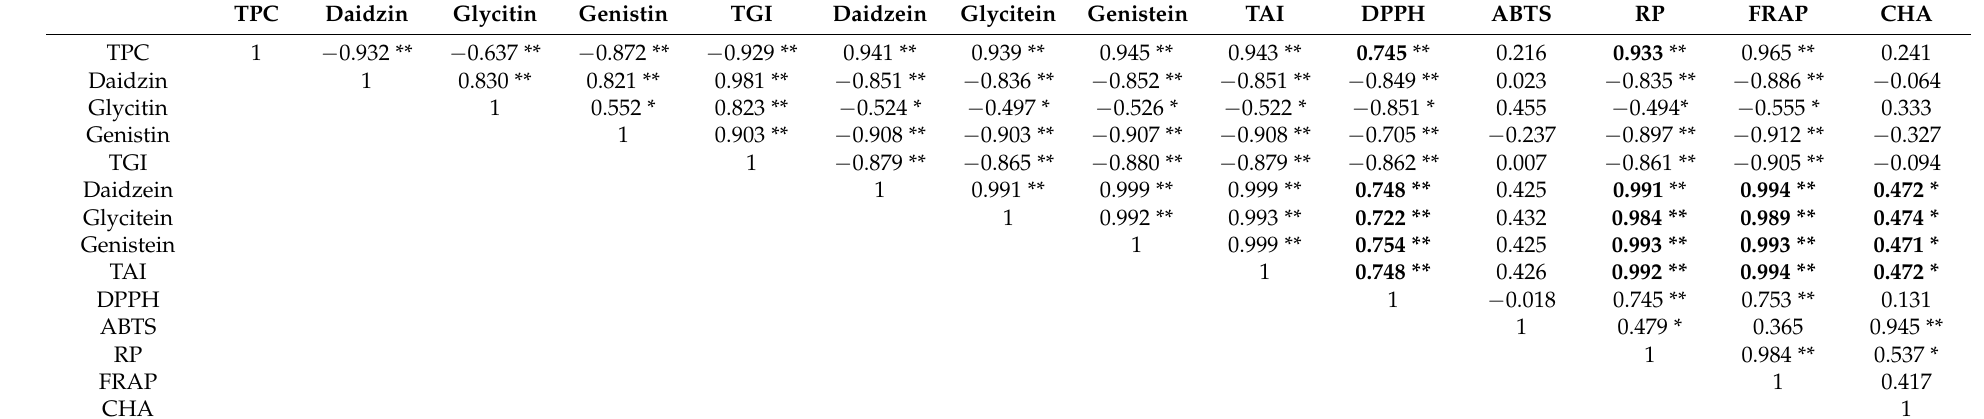
Table 6. Pearson’s correlation coefficients among total phenolic content (TPC), isoflavones content, and antioxidant activity.